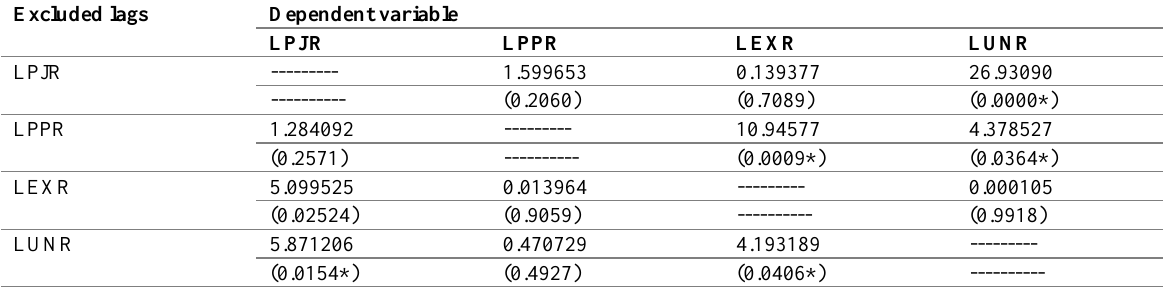
Table 6: Causation